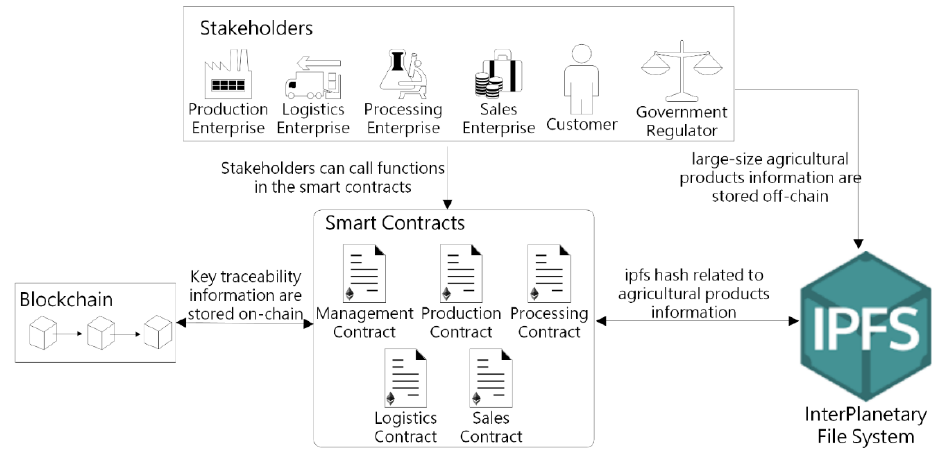
Figure 2. A high-level architecture for the proposed blockchain-based agricultural traceability sys-